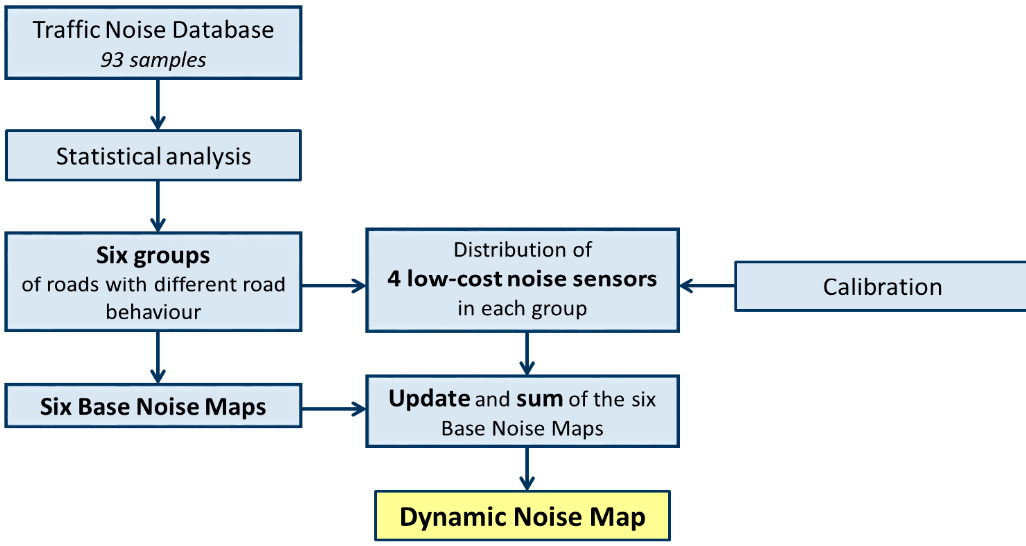
Figure 1. General block diagram of the followed processes in DYNAMAP.